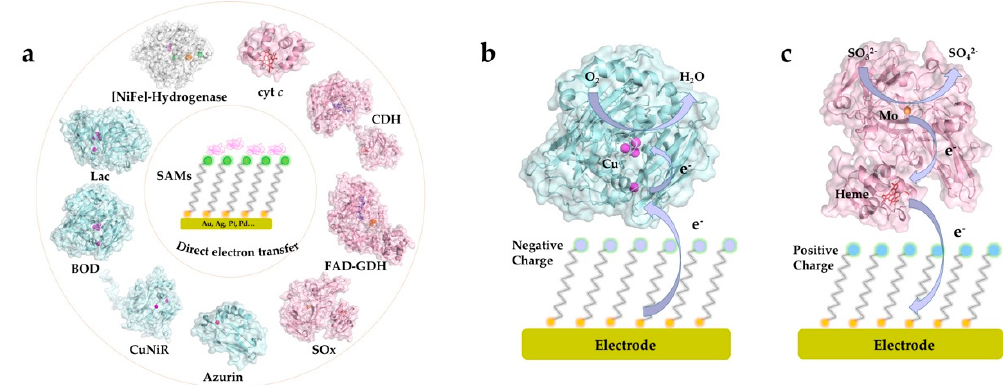
Figure 2. ( a ) Illustration of common proteins / enzymes capable of direct electron transfer (DET) on electrode modified by self-assembled molecular monolayers (SAMs). The proteins include: horse heart cytochrome c (cyt c ), PDB 1HRC; cellobiose dehydrogenase (CDH) from Neurospora crassa , PDB 4QI7; gamma-alpha subunit of FAD-dependent glucose dehydrogenase (FAD-GDH) from Burkholderia cepacia , PDB 6A2U; chicken liver sulfite oxidase (SOx), PDB 1SOX; Pseudomonas aeruginosa azurin T30R1, PDB 5I28; monomer of Achromobacter xylosoxidans copper nitrite reductase ( Ax CuNiR), PDB 1HAU; bilirubin oxidase from Myrothecium verrucaria (BOD), PDB 2XLL; laccase (Lac) from Trametes versicolor , PDB 1KYA; [NiFe]-hydrogenase from DesulfovVibrio Vulgaris Miyazaki F ( Dv MF), PDB 1UBU. Schematic view of representative DET processes of ( b ) mv BOD and ( c ) SOx on the electrode modified with negatively and positively charged SAMs, respectively.3.1. Heme-Containing Proteins